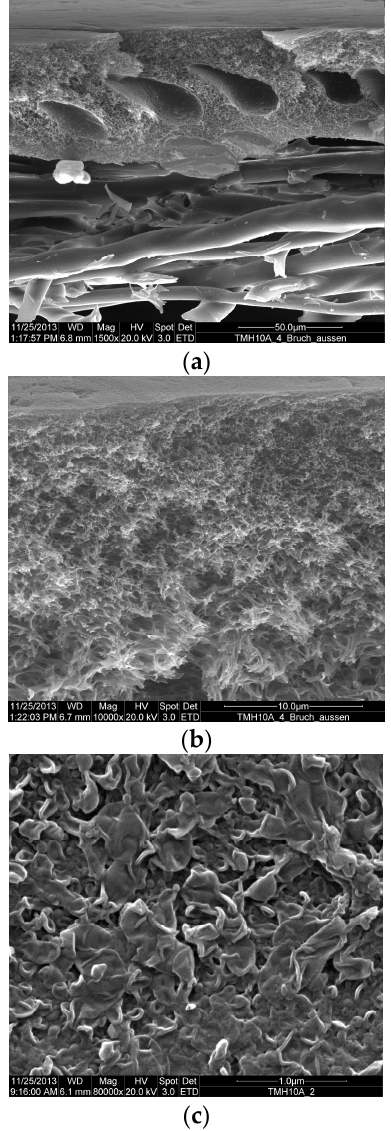
Figure 1. SEM micrographs for the TMH10 membrane: ( a ) overall cross-section for the membrane made of polyamide dense layer, polysulfone support and nonwoven fabric (from top to bottom), ( b ) thin-film composite membrane (polysulfone support and polyamide active layer), ( c ) typical “ridge-and-valley” polyamide surface morphology; measured by University of Duisburg-Essen using a LEICA S420 SEM, Wetzlar, Germany.